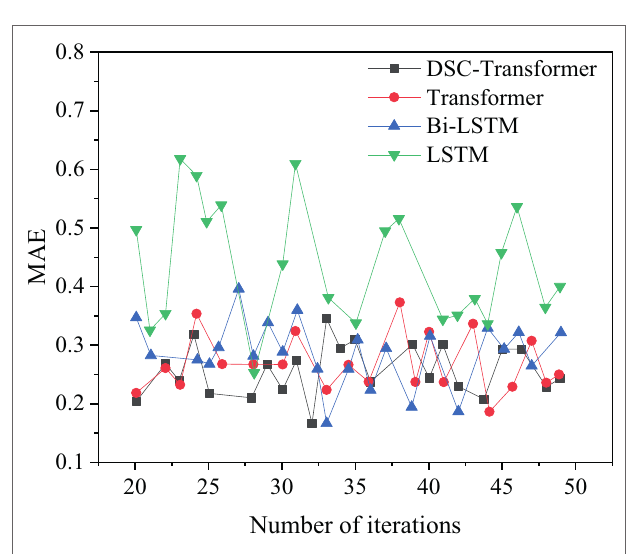
FIGURE 12 | Comparison of MAE values corresponding to models when using different